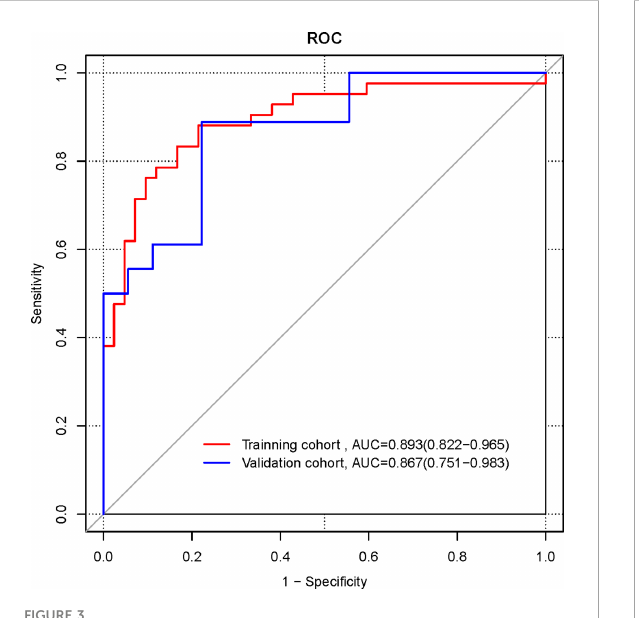
FIGURE 5 ROC curves of radiomics nomogram in the training and validation